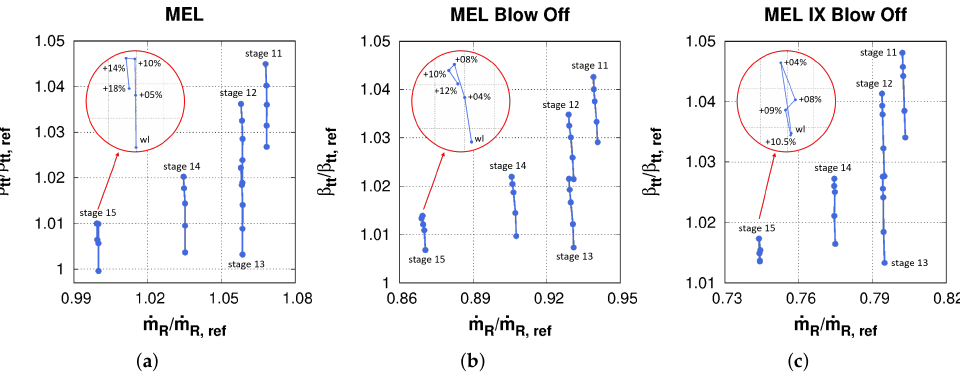
Figure 9. Compressor stages map for ( a ) MEL, ( b ) MEL+Blow-Off, ( c ) MEL+Blow-Off+IGV Extra